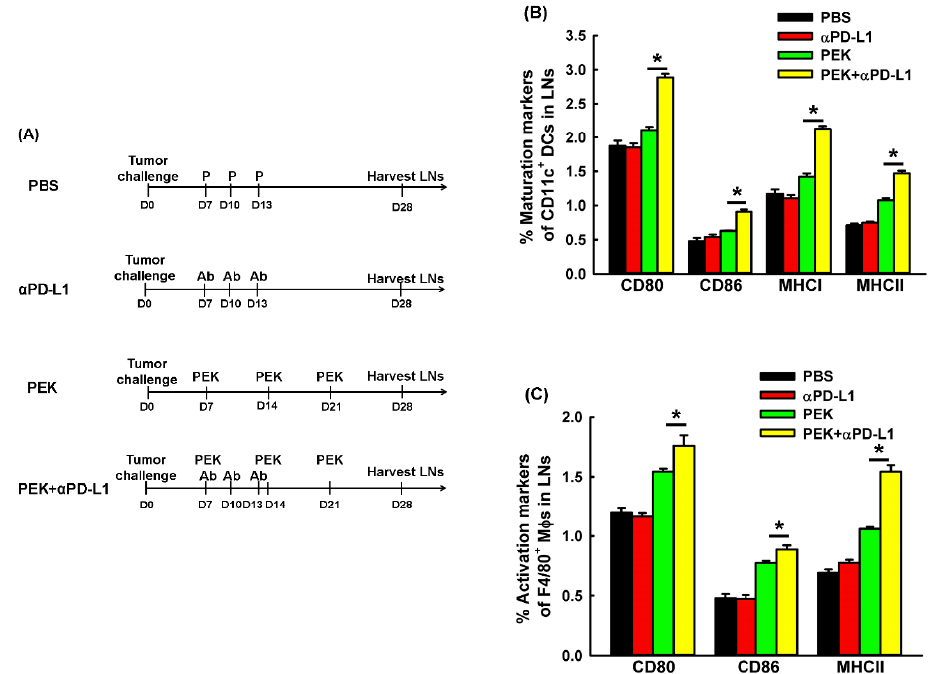
Figure 4. The effects of PD-L1 inhibition on the maturation of DCs and M1-like polarization of macrophages in tumor-draining lymph nodes (LNs) from mice vaccinated with the PEK protein vaccine. ( A ) Schematic graph showing the harvested processes of in vivo DCs and macrophages from tumor-draining LNs in mice vaccinated with PEK protein vaccine with or without anti-PD-L1 Ab. ( B ) Percentages of maturation status of DCs in tumor-draining lymph nodes from mice on day 28 after tumor challenge in various groups, as determined by flow cytometry ( n = 5 per group, mean ± SEM). The percentage of CD11c + DCs expressing CD80 significantly increased in mice treated with the PEK protein vaccine plus anti-PD-L1 Ab compared with mice treated with the PEK vaccine plus PBS (*: p < 0.001, Student’s t -test). The percentage of CD11c + DCs expressing CD86 significantly increased in